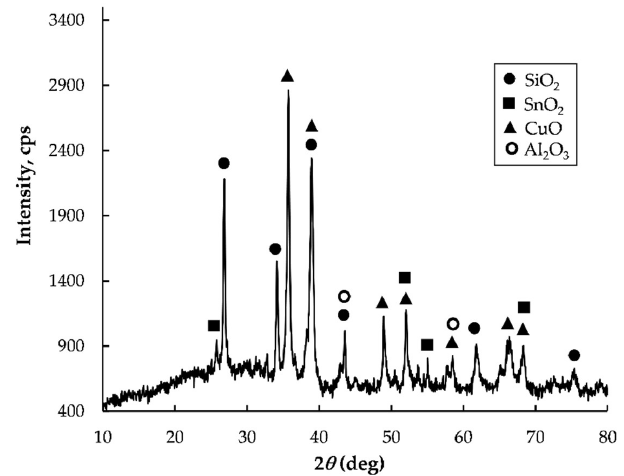
Figure 1. Particle size distribution of waste printed circuit boards (WPCBs) ash.